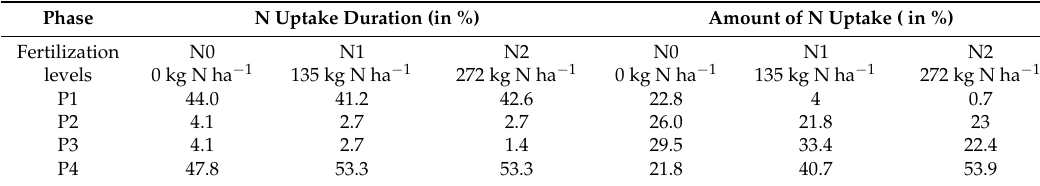
Table 1. Temporal structures of N uptake during the second phase of growth (from rosette stage to harvest) of B. napus plants growing under field conditions after three levels of fertilization; relative importance of each phase P i phase duration and amounts of N accumulated during each phase of N acquisition. These values are calculated from data in Figure